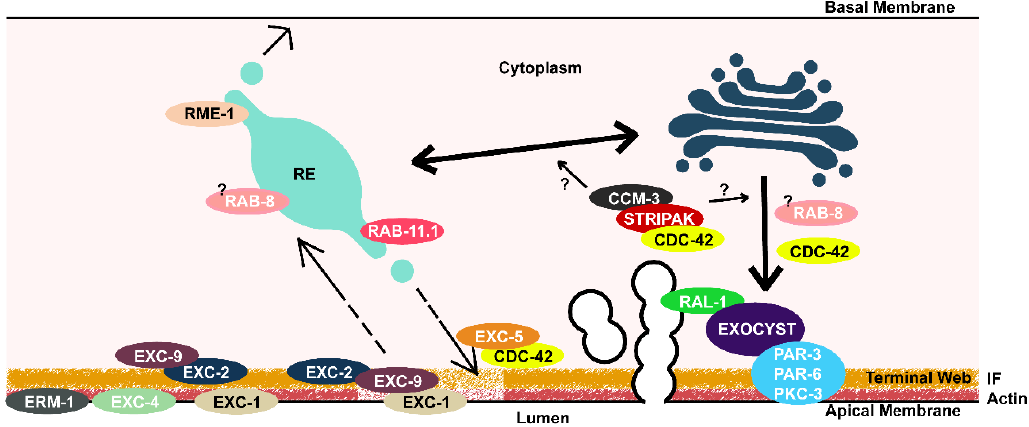
Figure 4. Speculative model of formation and maintenance of canal luminal shape. Lumen on bottom, basal membrane and neighboring hypodermal cell on top. Ezrin/Radixin/Moesin (ERM)-1 and EXC-1(IRG) proteins are seen at an apical membrane. EXC-2/IF and two other intermediate filaments, along with actin, make up the terminal web. The EXC-4/CLIC channel is apical. EXC-9 is retained to the apical surface by EXC-2. If terminal web is damaged or thinned during growth (light area shade of terminal web), EXC-9 can make contact with and presumably activate EXC-1. Ras domains of EXC-1 presumably trigger trafficking machinery at the recycling endosome (RE). Trafficking may be directed from the RE to apical surface, or possibly via Golgi via the STRiatin-Interacting Phosphatase And Kinase (STRIPAK) complex. EXC-5/FGD Guanine Exchange Factor activates CDC-42 to polymerize actin to bring vesicles to apical surface where the Exocyst complex and PAR complex complete fusion.